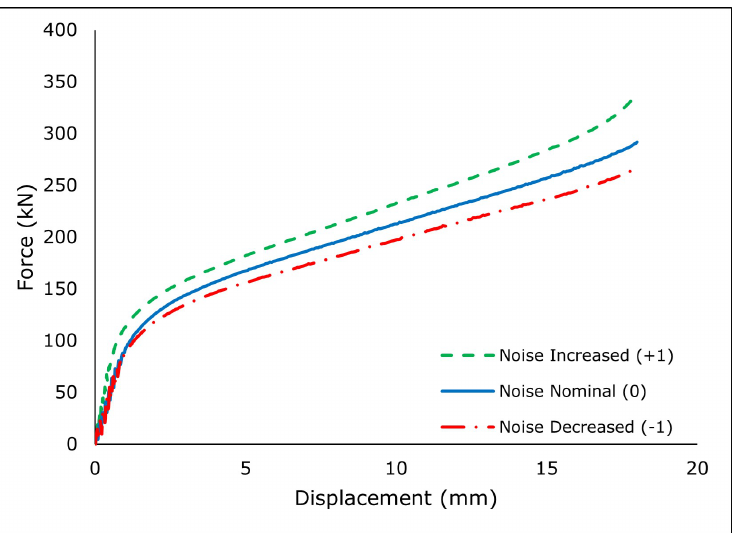
Figure 11. Force-Displacement Curve of Optimum Model. Based on the SEA value, the S/N ratio and the mean value is obtained, 38.63 dB and 85.47 kJ/kg, respectively. Using the performance of the baseline model (31.02 dB and 40.59 kJ/kg), the improvement based on the finite element simulations are 7.61 dB for S/N and 44.88 kJ/kg for the